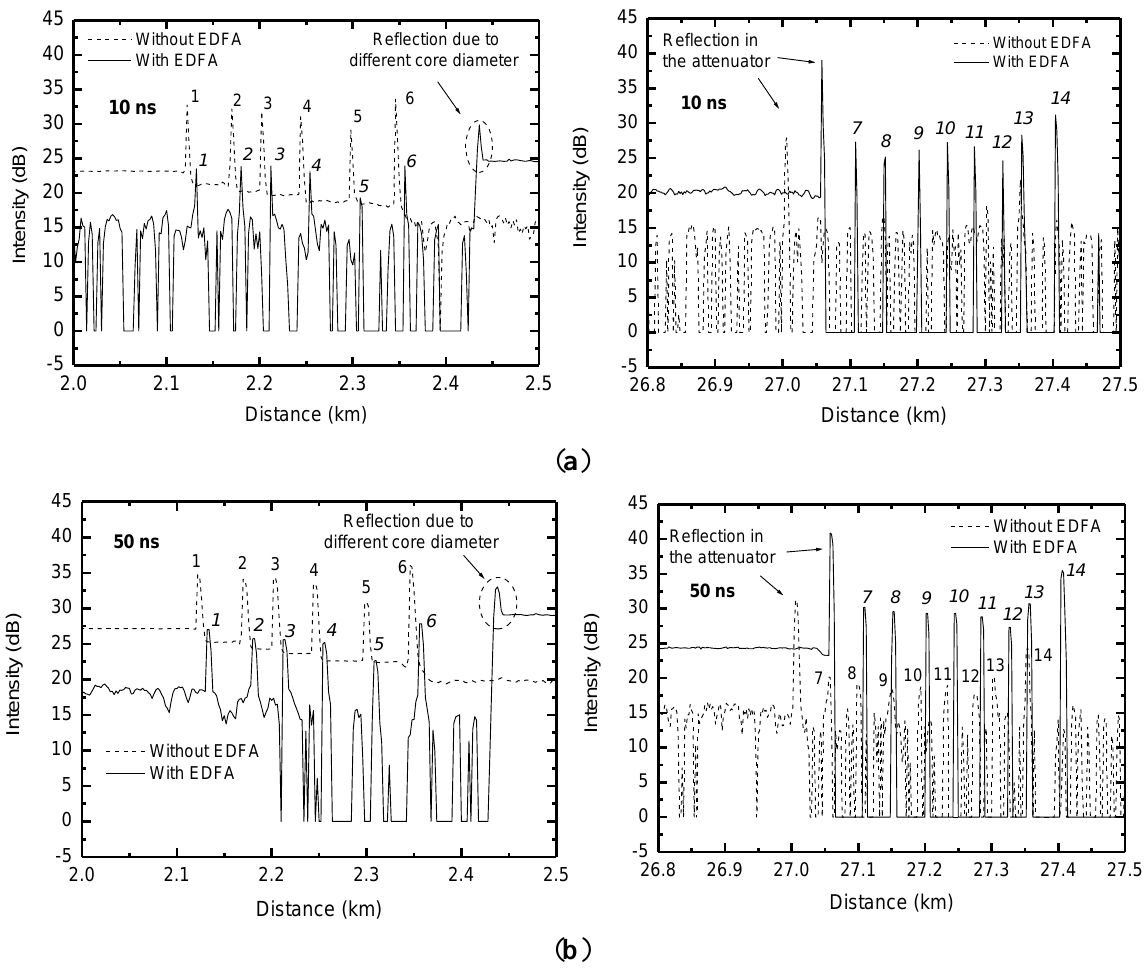
Figure 2. OTDR traces of the amplified (solid line) and non-amplified (dashed line) multipoint sensor system for OTDR pulsewidth of ( a ) 10 ns and ( b ) 50 ns. Pump power at EDF input is 17